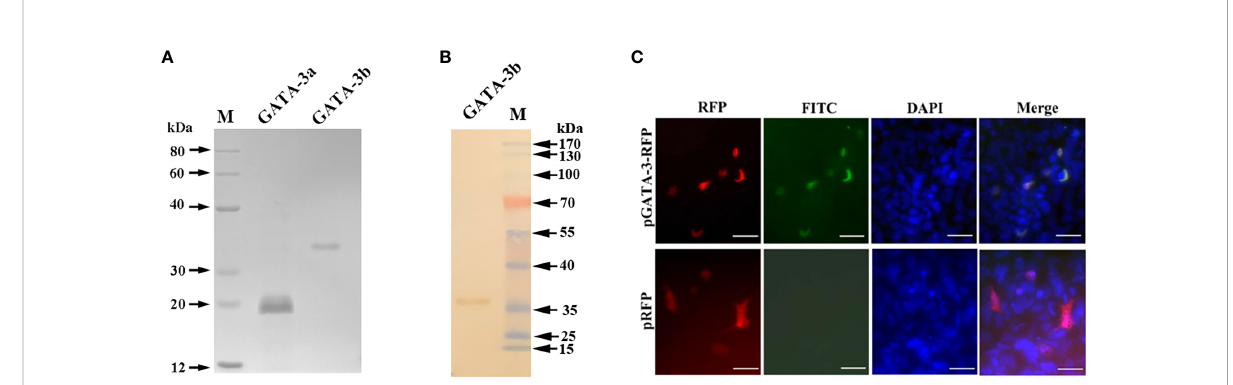
FIGURE 1 Production and validation of anti-r Ss GATA-3 antibodies. (A) The puri fi ed r Ss GATA-3 proteins were shown by SDS-Page. Lane M: marker; Lane GATA-3a: puri fi ed r Ss GATA-3a proteins; Lane GATA-3b: puri fi ed r Ss GATA-3b proteins. (B) Western blotting shows the speci fi city of the rat anti- r Ss GATA-3b antibodies. Lane M: marker; Lane GATA-3b: r Ss GATA-3b proteins incubated with puri fi ed anti-r Ss GATA-3b antibodies. (C) Overexpression of Ss GATA-3-RFP in CHSE-214 cells for detection of the speci fi city of anti-r Ss GATA-3b antibodies. The nuclei were stained with DAPI. Bar = 10 m